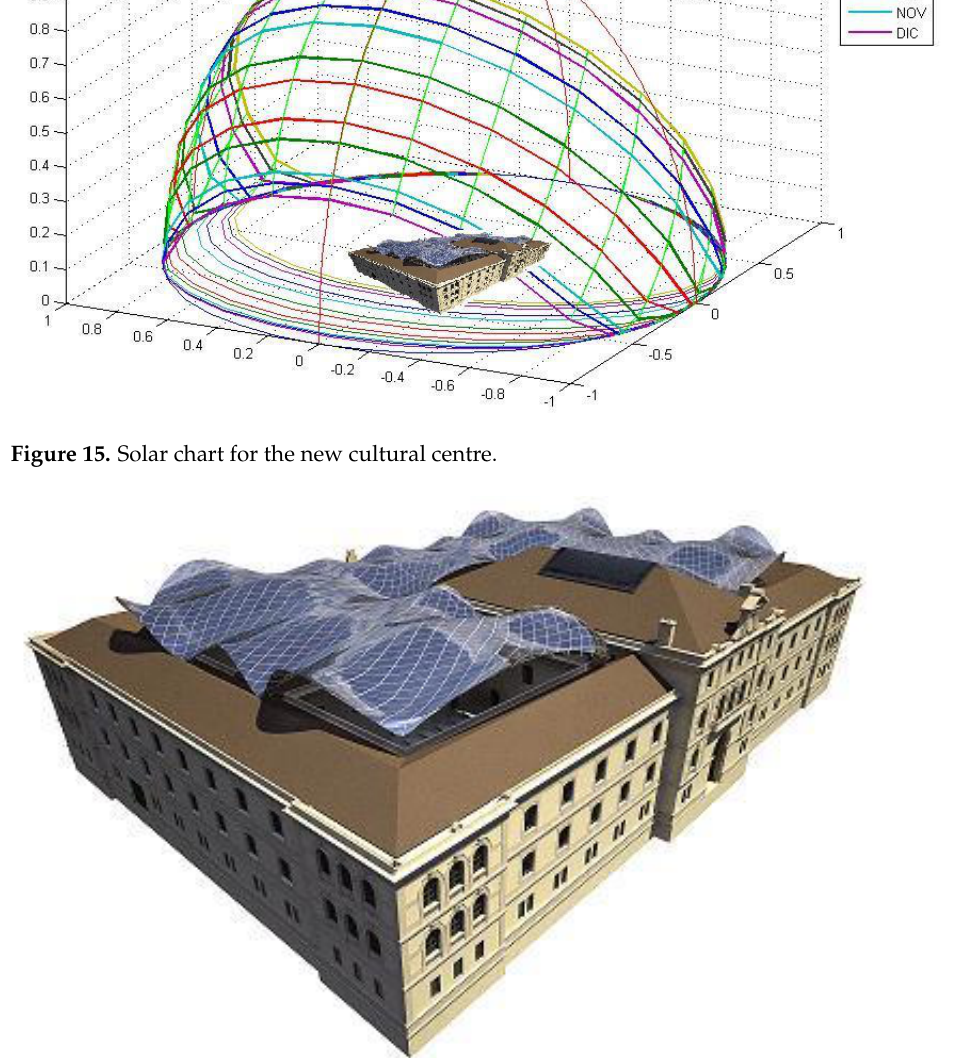
Figure 17. Vertical distribution of temperatures in deg. C, during summer.